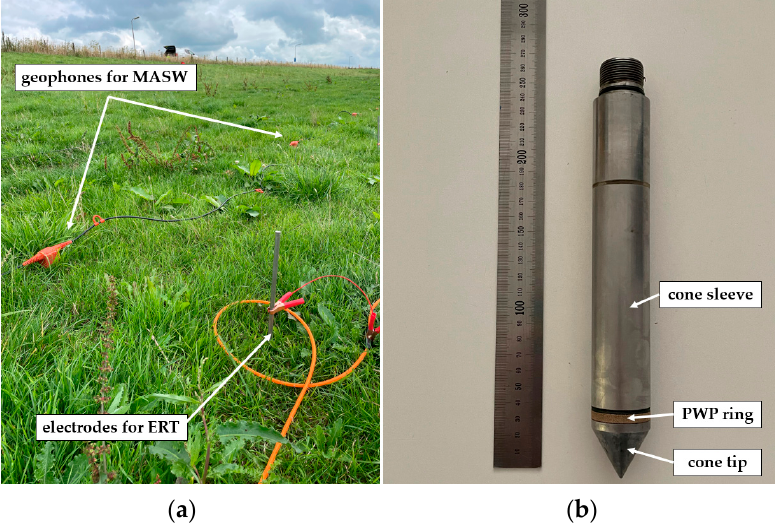
Figure 6. In situ investigation methods: ( a ) MASW geophones and ERT electrodes during the inves- tigation; ( b ) CPT cone parts. investigation; ( b ) CPT cone